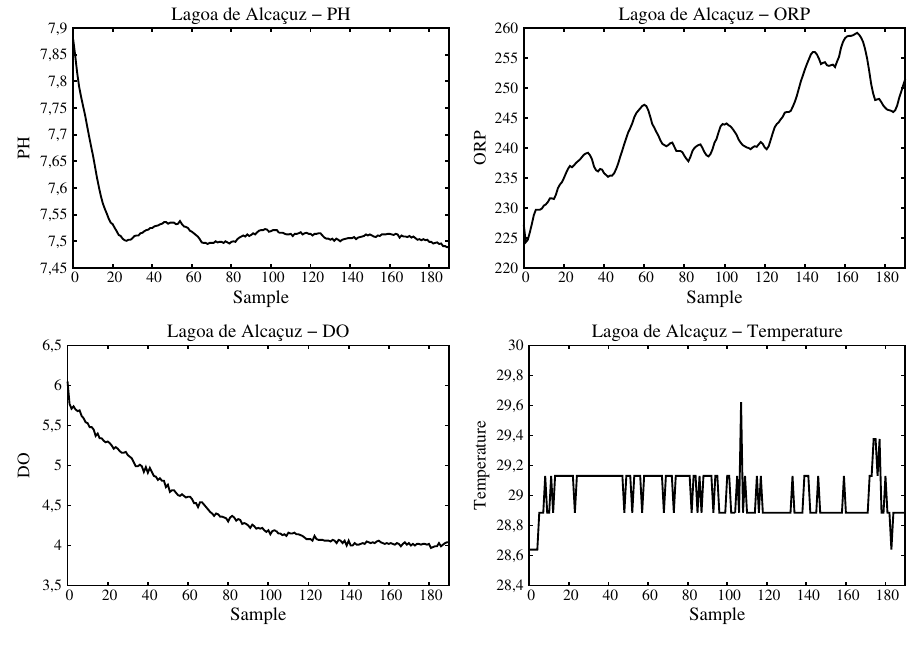
Figure 12. Values of data processed for Alcaçuz Lake.